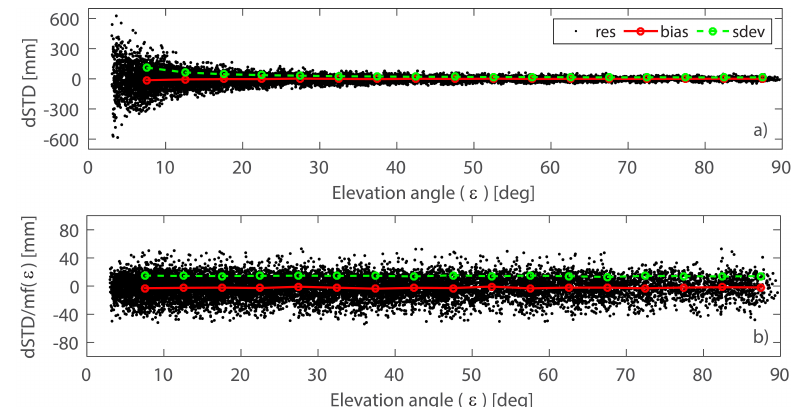
Figure 6. Differences calculated as GNSS minus ray-traced delays in terms of ( a ) slant total delay and ( b ) converted to zenith direction with mapping functions. Red and green lines show mean bias and standard deviation respectively, averaged in 5 degree